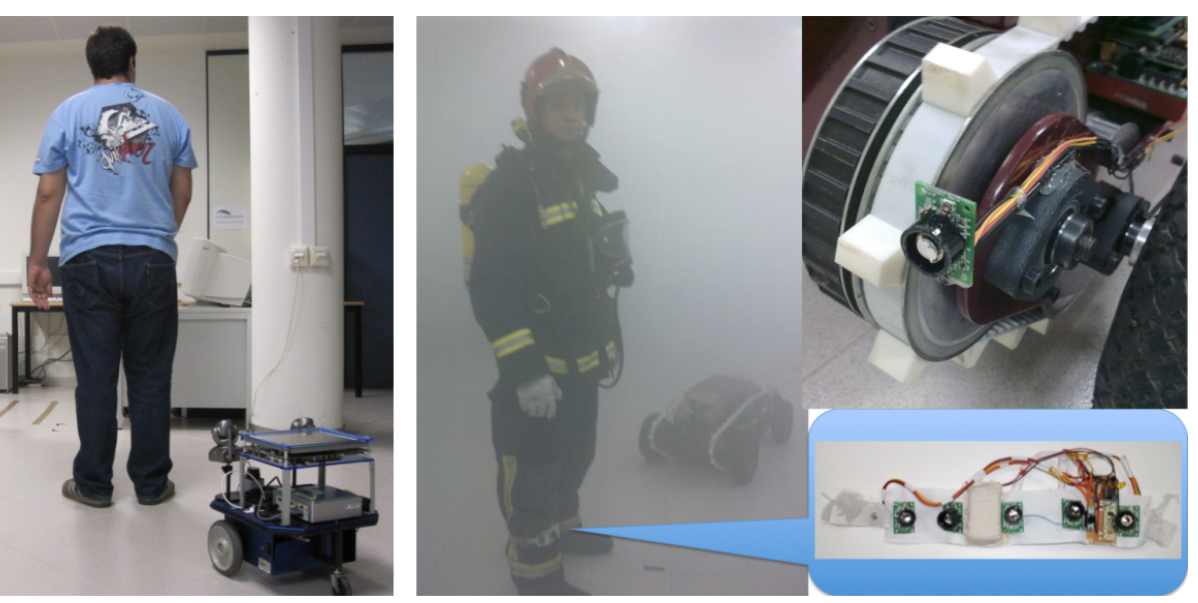
Figure 1. Robot following a human using computer vision (left). Robot following a firefighter using ultrasound and radio sensors. An ultrasound ring transmitter is attached to the firefighter’s leg. The robot can follow the firefighter using the received signals